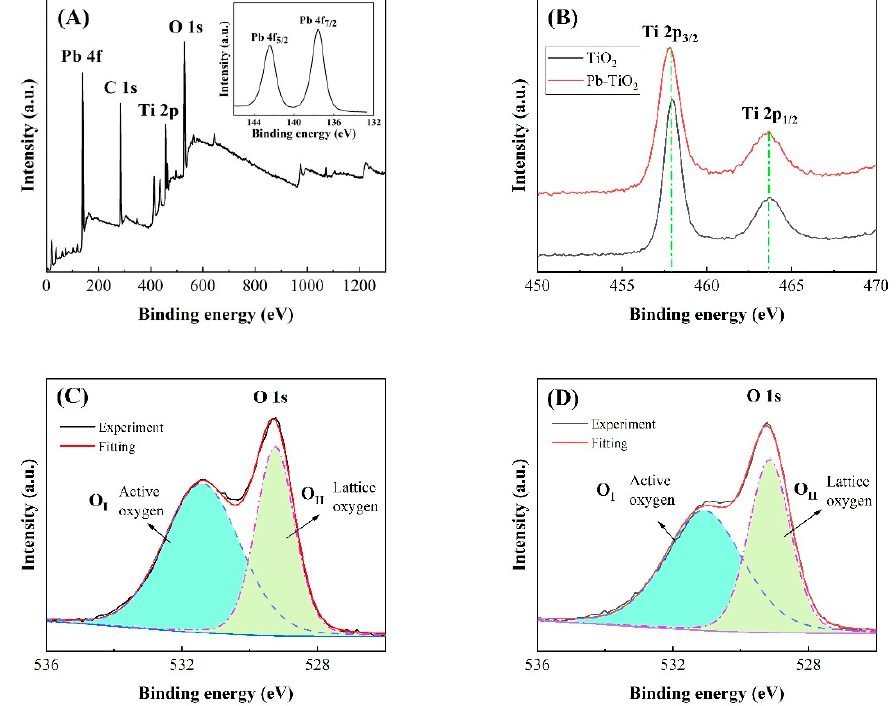
Figure 4. XPS spectra of the surface element states; full spectrum of Pb-TiO 2 . ( A ), Ti2p spectrum ( B ), and O1s spectrum of TiO 2 ( C ) and Pb-TiO 2 ( D